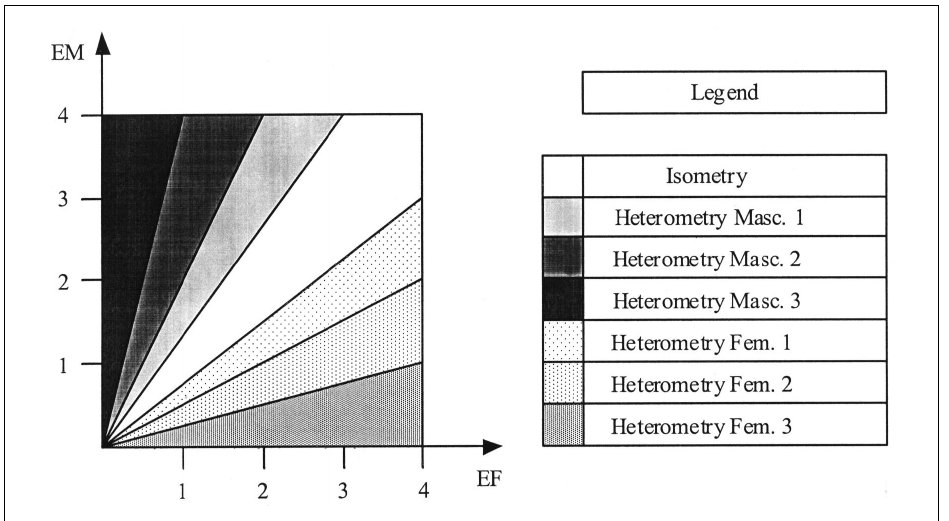
Figure 3 . Fields formed by angle